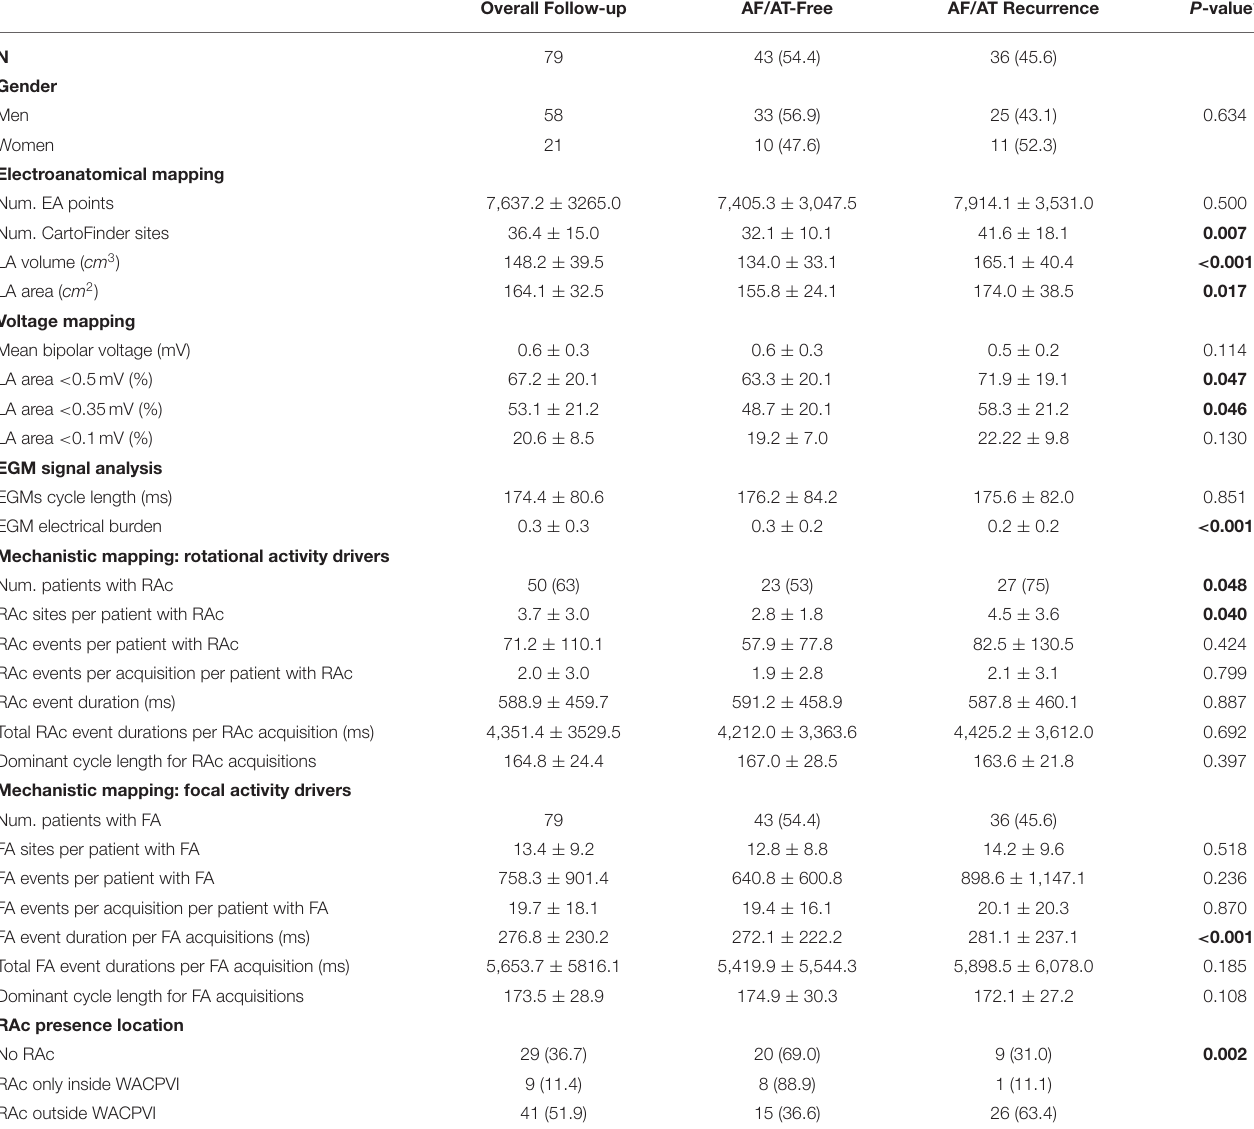
TABLE 3 | Atrial fibrillation/Atrial tachycardia (AT) recurrence analysis. Overall Follow-up AF/AT-Free AF/AT Recurrence P